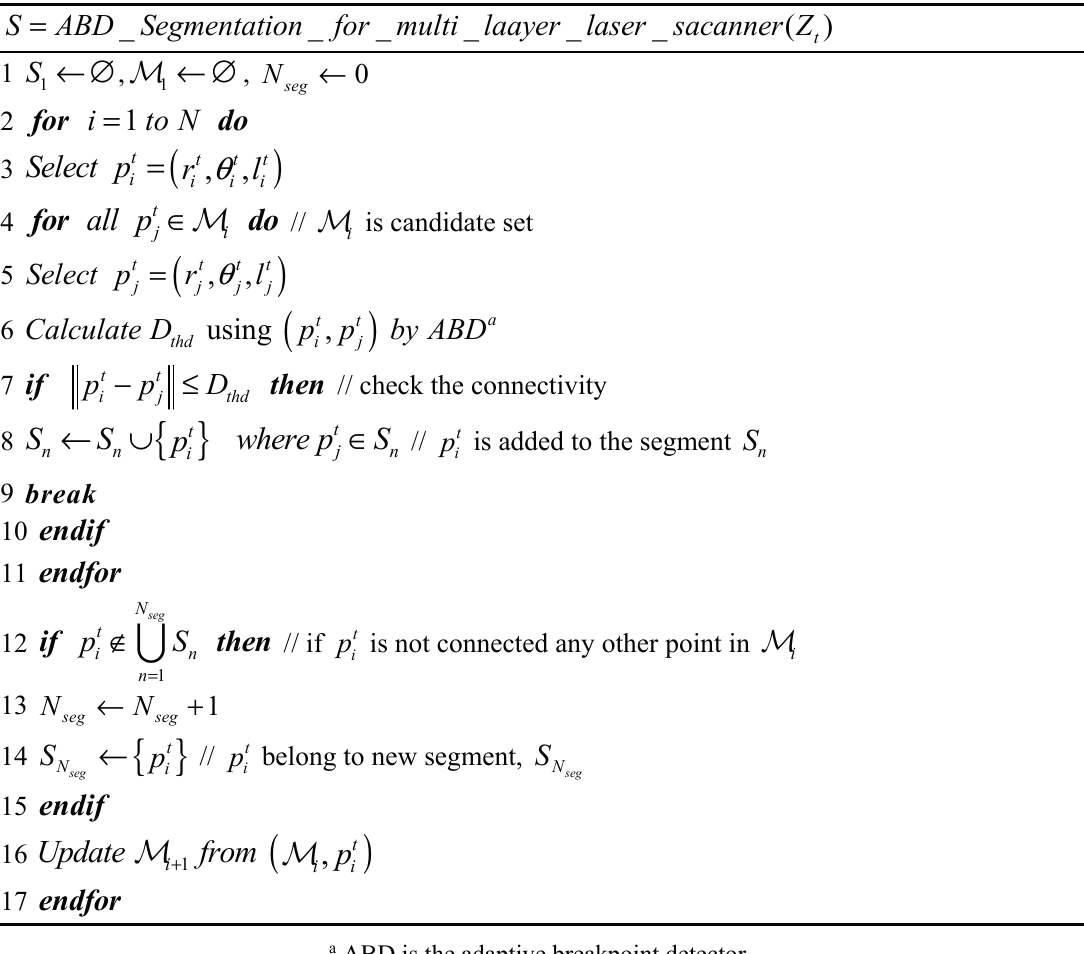
Table 1. ABD segmentation for multi-layer laser scanner.